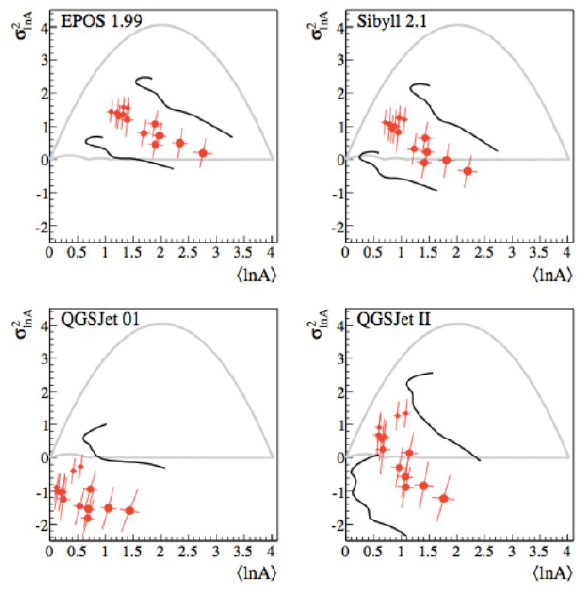
Figure 3: The Pierre Auger data in the ( < lnA > , σ 2 ) plane for different hadronic interaction models. lnA Grey contours limit the allowed region, the systematic uncertainties are shown by the black lines.